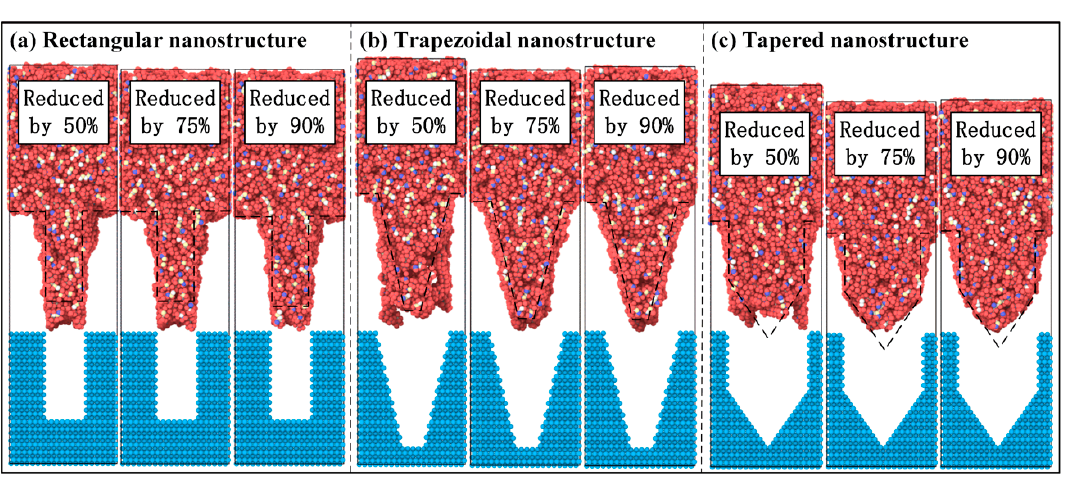
Figure 6. Morphologies of three nanostructures after reducing the adhesion energy at PP-Ni interface: ( a ) Rectangular nanostructure, ( b ) trapezoidal nanostructure, ( c ) tapered nanostructure.